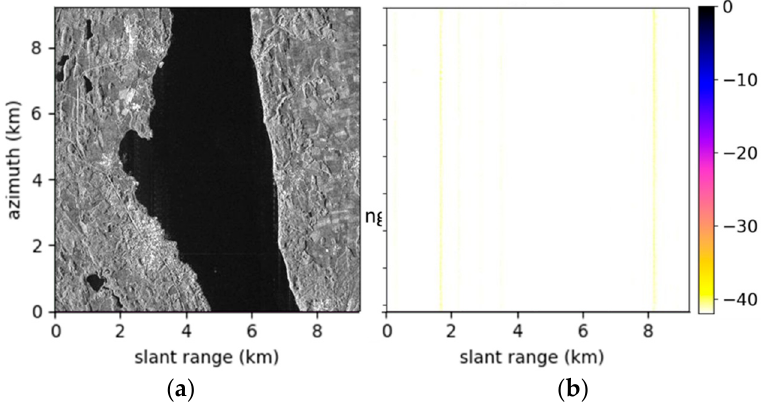
Figure 15. Focused image after multi-focus postprocessing for the proposed technique with 𝑁 = 5 showing ( a ) both the scene and the nadir echo displayed in linear scale and ( b ) nadir echo only displayed in dB.